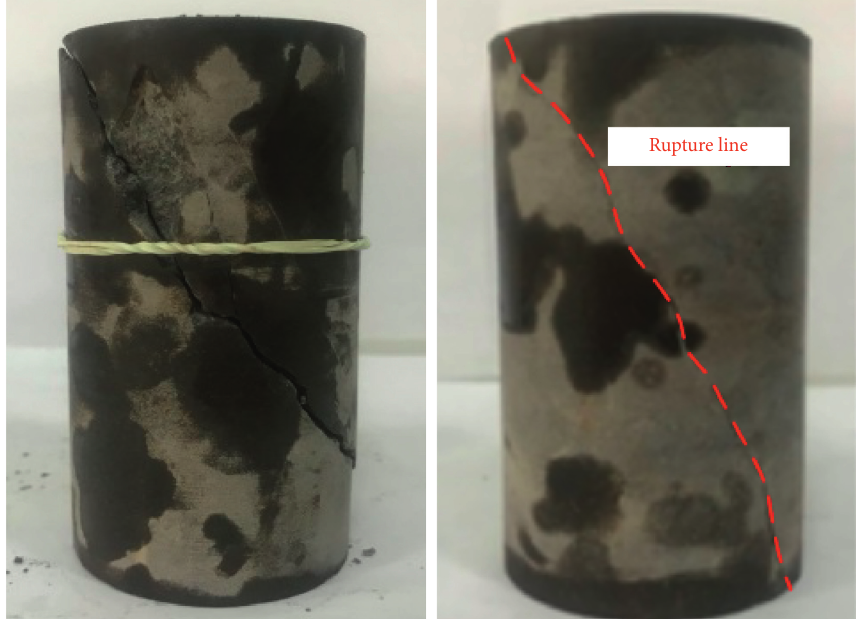
Figure 5: Fracture form of mudstone specimen in a triaxial compression